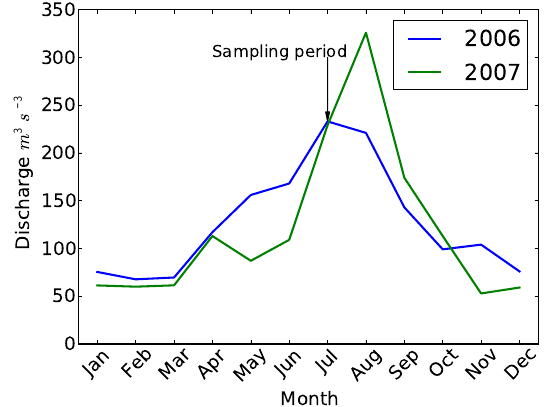
Figure 3. Water discharge of the Kaidu River at the Dashankou sta- tion, downstream of the grassland (monthly average). Source: Xin- jiang Institute for Ecology and Geography (unpublished